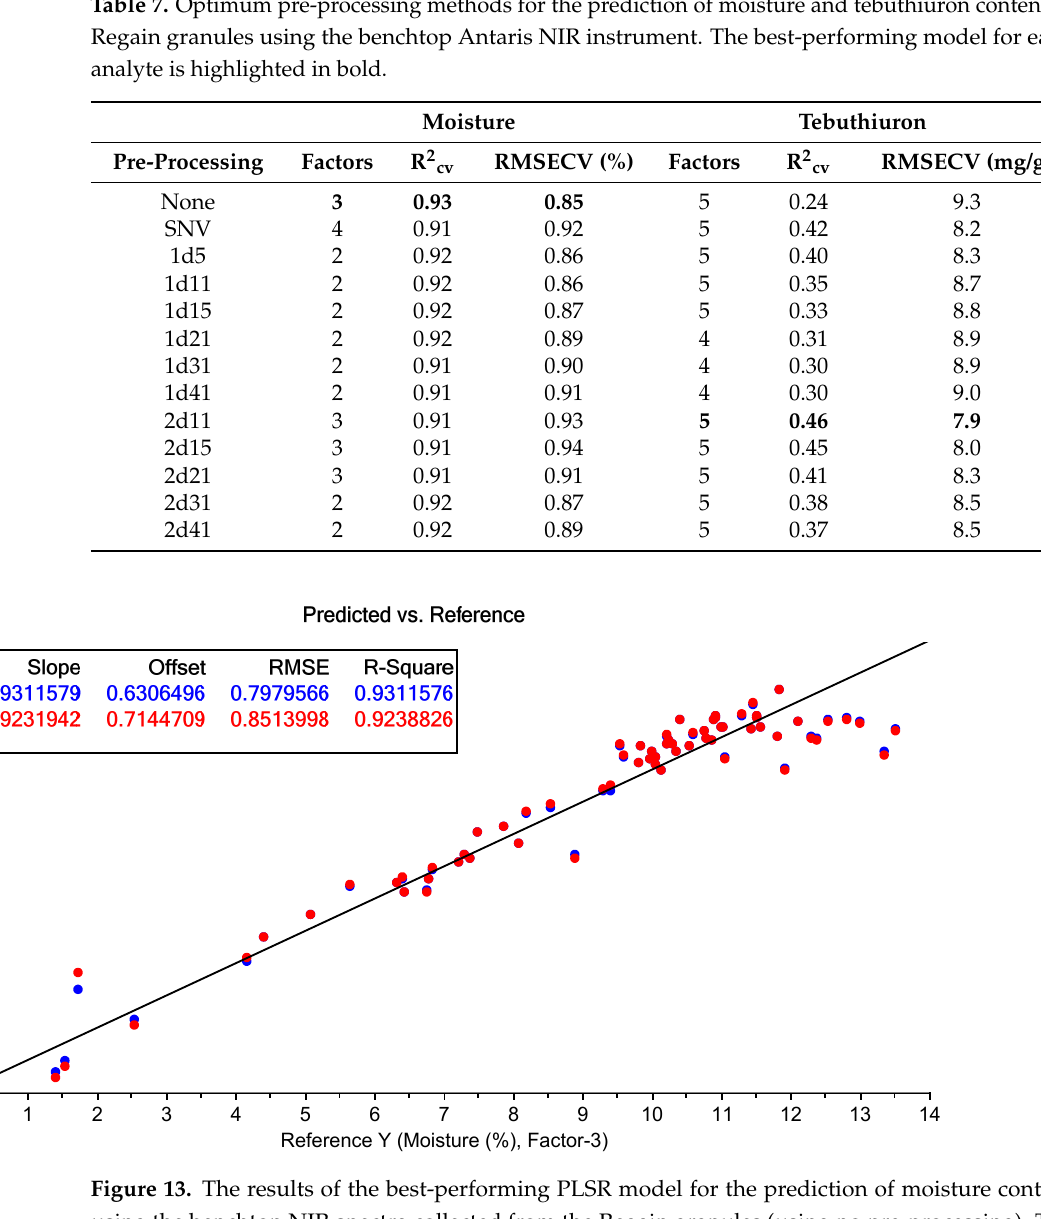
Figure 14. The results of the best-performing PLSR model for the prediction of tebuthiuron content using the benchtop NIR spectra collected from the Regain400 samples (using 2d11 pre-processing). The blue points show the model calibration, while the red points show the model cross-validation. The model accuracy was quite high for moisture content (R 2cv of 0.93 and RMSECV of 0.85%); however, the prediction results for tebuthiuron content were somewhat poorer (R 2cv of 0.46 and RMSECV of 7.9 mg/g). However, the RMSECV of the tebuthiuron calibra- tion was only slightly lower than the standard deviation of the analytical (HPLC) refer- ence method (7.0 mg/g). Consequently, this indicates that the accuracy of the NIR method was approaching the maximum accuracy expected using this reference method. The model loadings for the moisture content PLSR model showed positive contribu- tions from the peaks at 1936, 1450 and 1190 nm (Figure 15). These regions correspond to the H 2 O 1st overtone, amide second overtone and C-H second overtone, respectively. The greatest contribution was observed from the H 2 O 1st overtone, confirming that the model